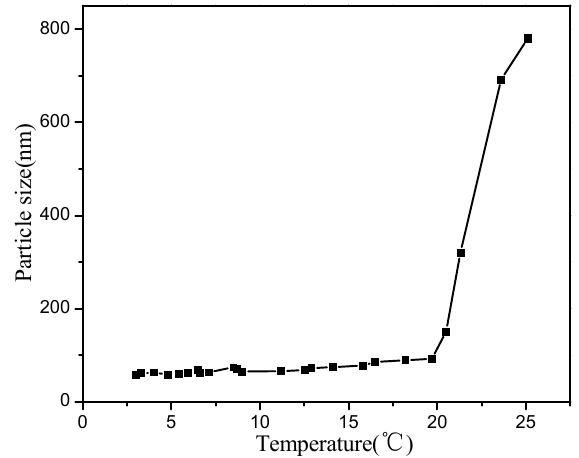
Figure 10. The diameter of nanomicell vs. Temperature for each temperature, measuring the diameter after holding the temperature for 10 min. Solution concentration: 2 mg·mL − 1 ; heating rate: 0.1 aqueous·min − 1 ; pH = 4.